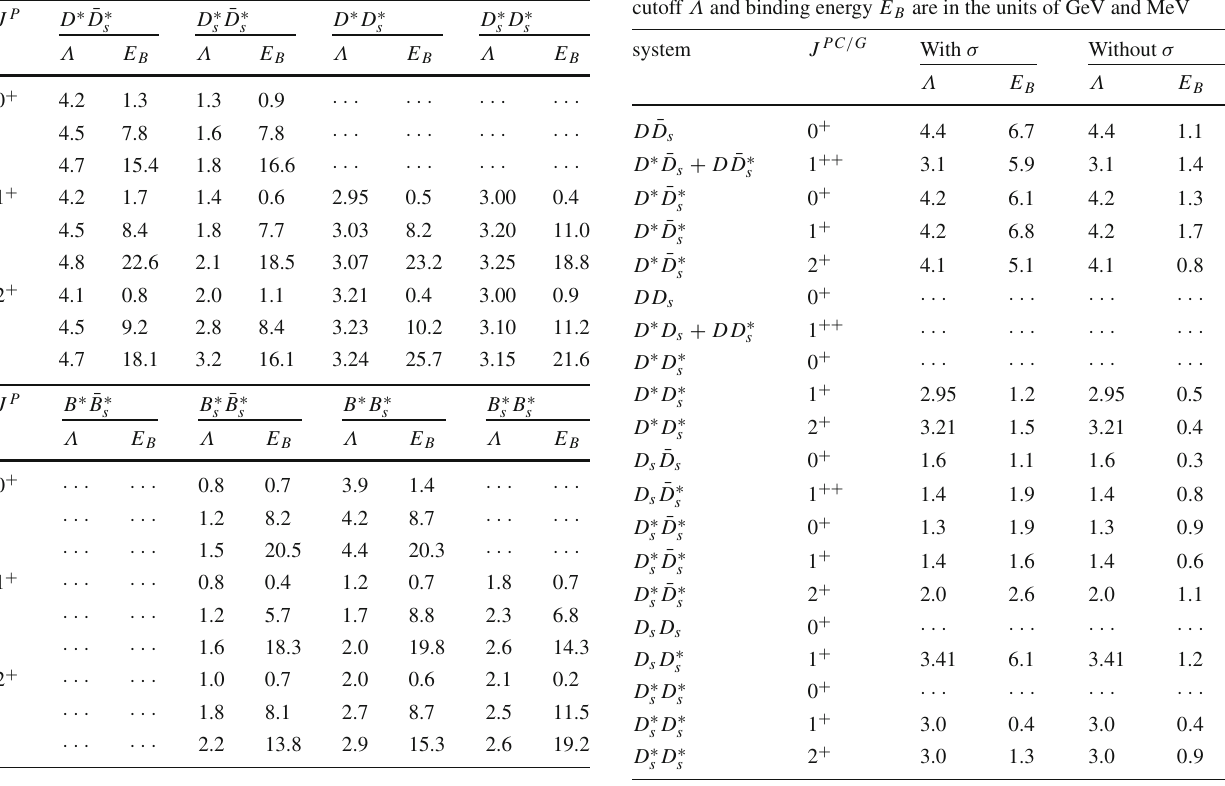
Table 5 The binding energies of the bound states from the interac- tions D ∗